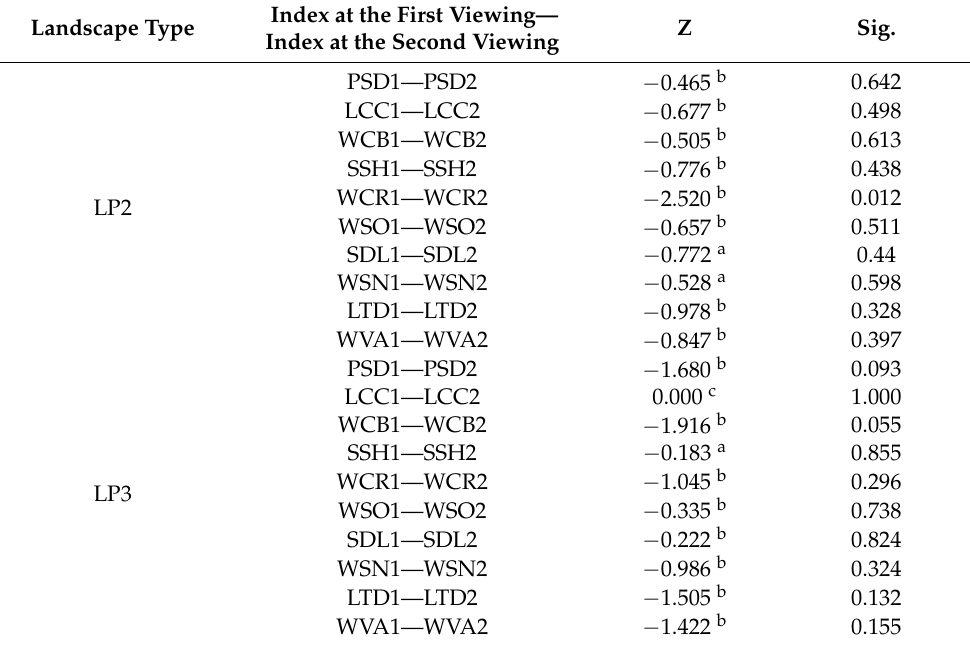
Table A1. Cont. Landscape